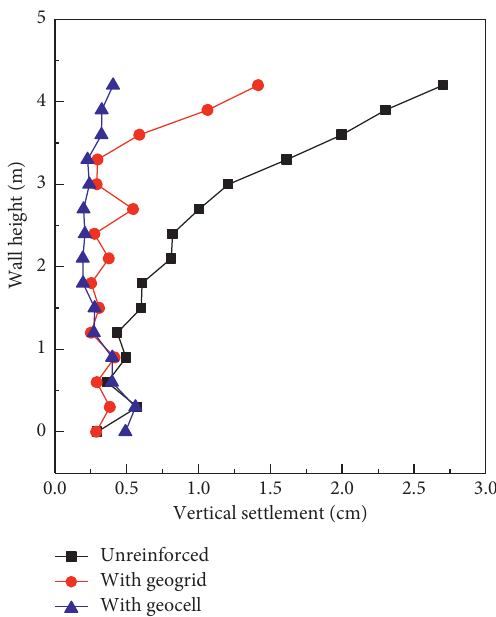
Figure 12: Vertical displacement curves of three retaining wall edges.